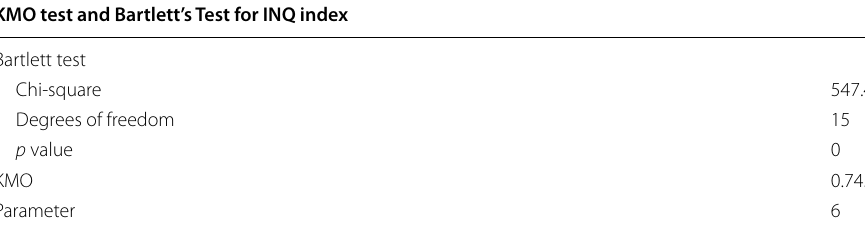
Table 3 KMO test and Bartlett’s Test for INQ index KMO test and Bartlett’s Test for INQ index Bartlett